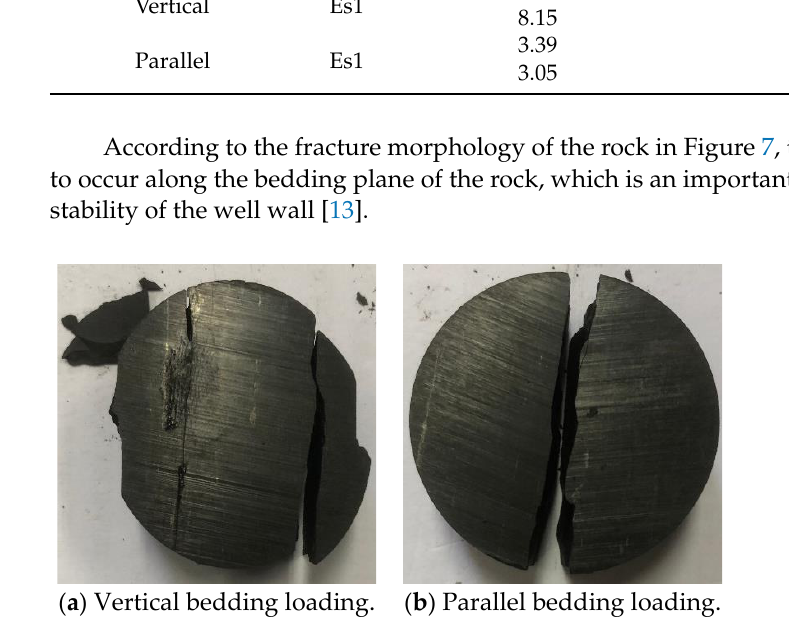
Figure 7. Fragmentation morphology of loaded shale in different bedding directions.